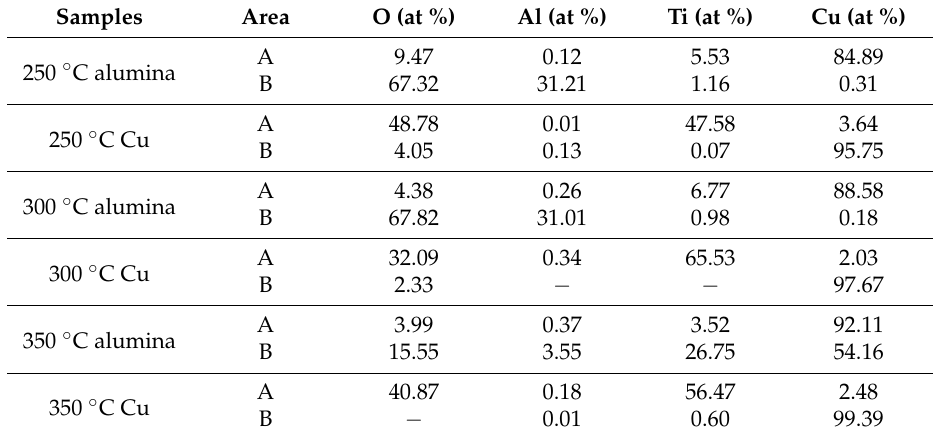
Figure 7. SEM fracture surface of heterogeneous diffusion bonding on ( a – c ) alumina substrate side and ( d , e ) copper substrate side under 250, 300, and 350 ◦ C hot vacuum process, respectively. Table 2. EDS results of elemental compositions (at %) of area A and B in each fracture surface of the alumina and copper substrate side under 250, 300, and 350 ◦ C processes,